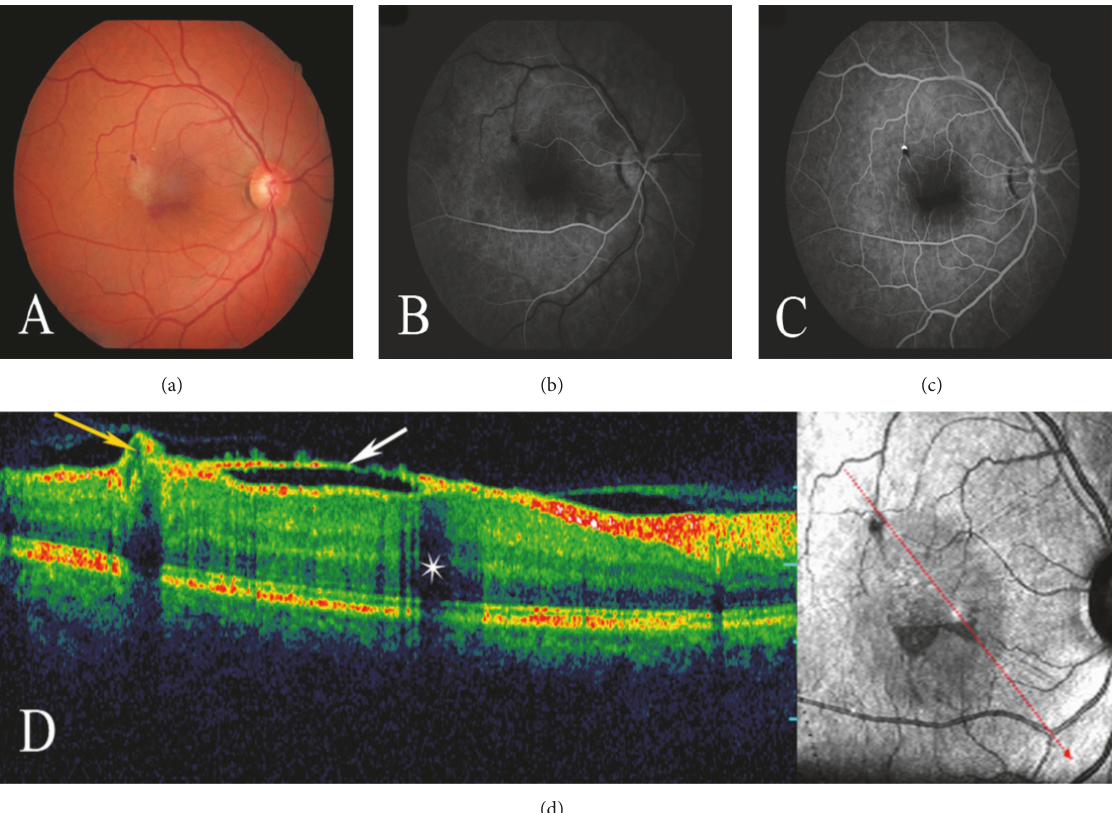
Figure 2: One month after laser treatment, (a) fundus photography of the right eye shows only small amount of residue blood at the lower edge of the detached ILM. (b, c) Fluorescein angiography shows a round area of hyperfluorescence which is prominent in venous phase and corresponds to a macroaneurysm of the macular branch of the superotemporal vein at the bifurcation site. (d) Optical coherence tomography demonstrates the detached and wrinkled ILM (white arrow) extending from the site of the macroaneurysm (yellow arrow) to the inferior margin of the residual sub-ILM blood causing a shadowing effect (star) in the